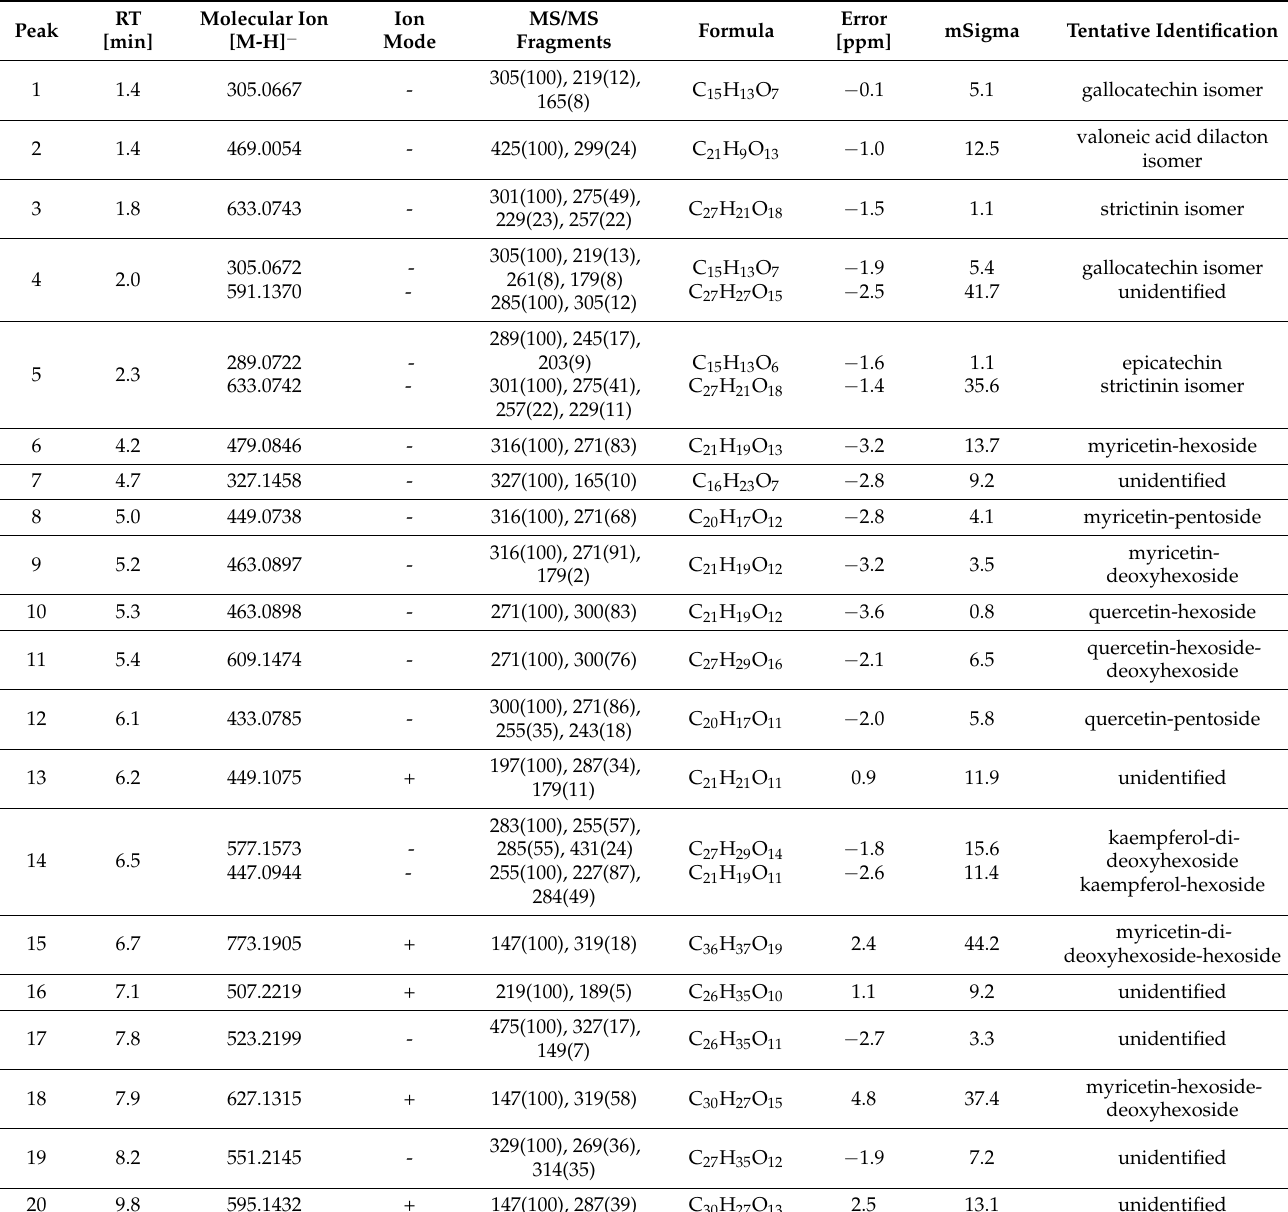
Table 6. Compounds identified in the cistus ( Cistus L.) extract using UHPLC-QTOF-MS/MS. Compound numbers corre- spond to those indicated in Figure